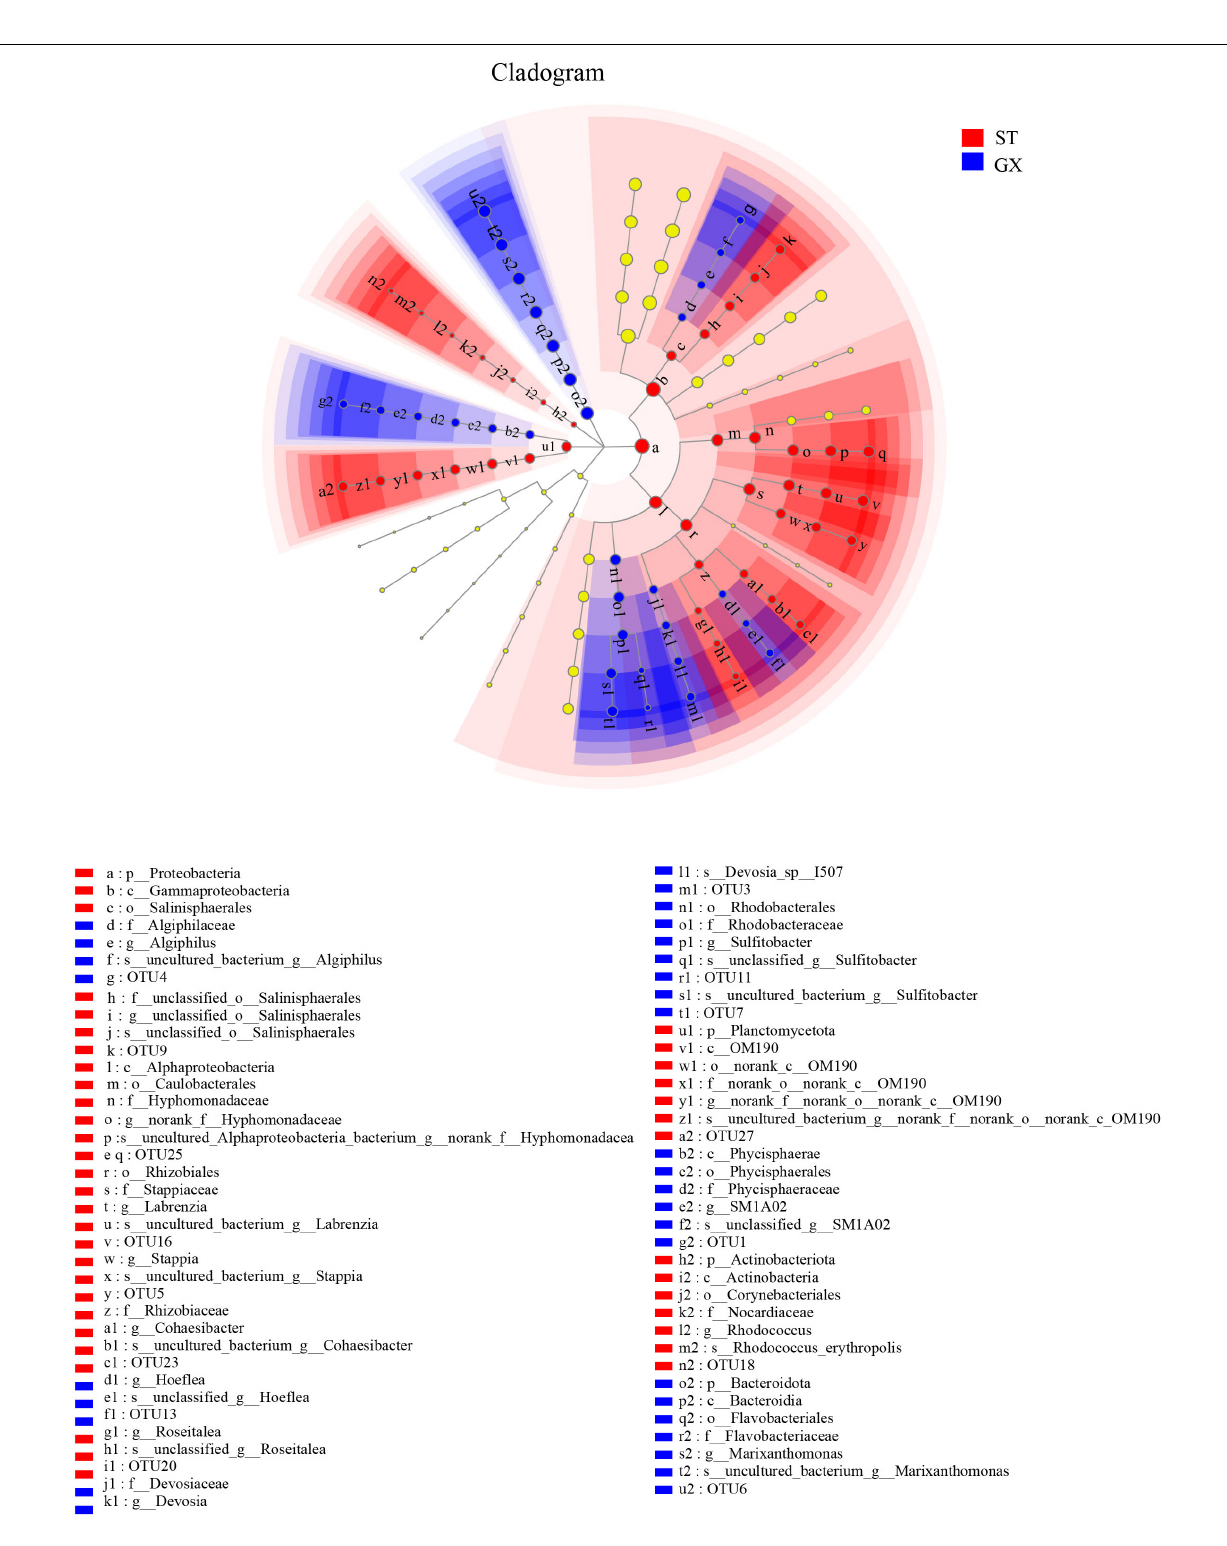
Frontiers in Microbiology |